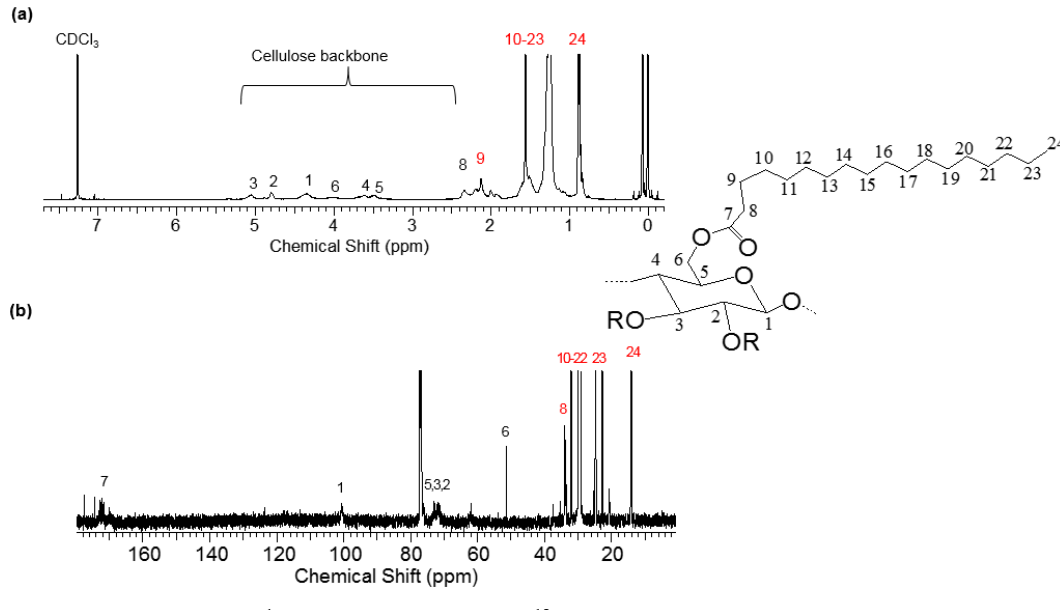
Figure 1. 1 H NMR spectrum ( a ) and 13 C NMR spectrum ( b ) of the Bz–Cell.